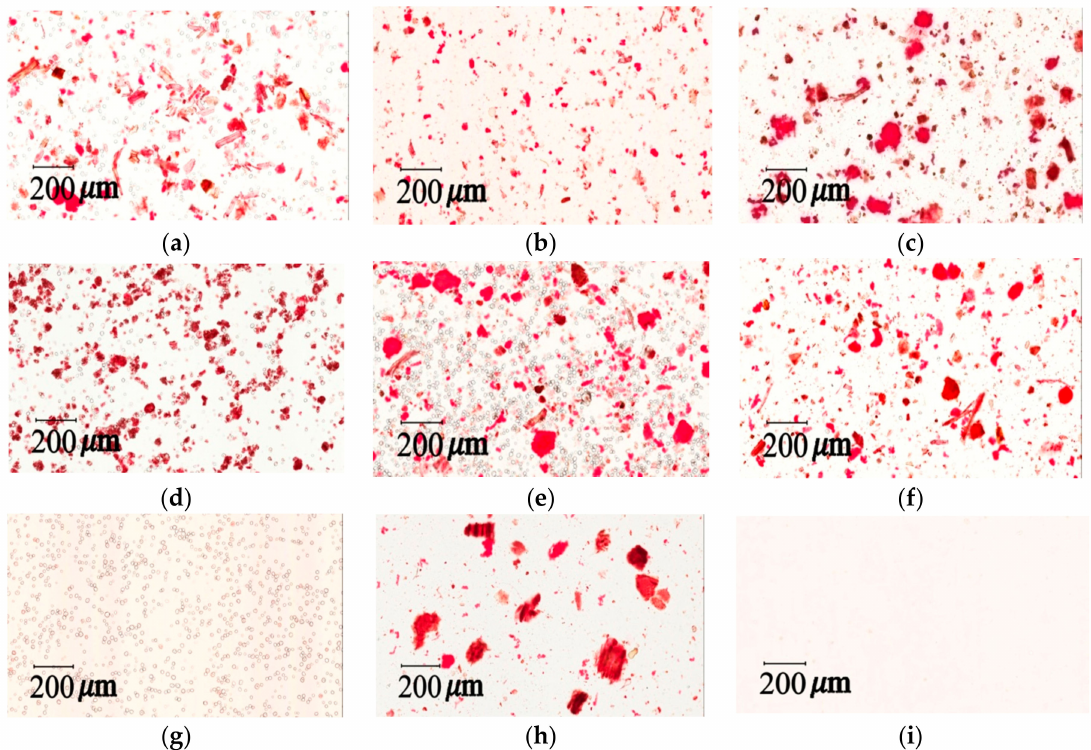
Figure 4. Light microscopy photographs of Congo red staining: ( a ) herbal pharmaceutical product XSLJZT of brand A; ( b ) herbal pharmaceutical product XSLJZT of brand B; ( c ) herbal pharmaceutical product XSLJZT of brand C; ( d ) herbal pharmaceutical product XSLJZT of brand D; ( e )